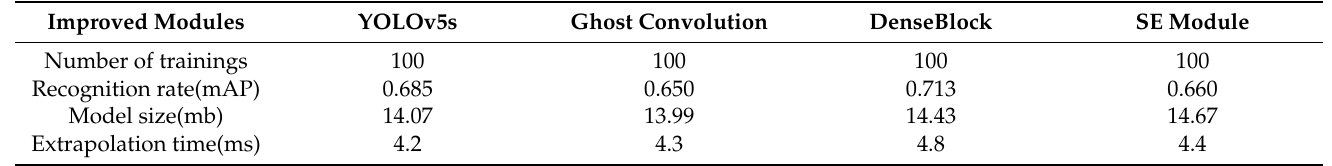
Table 5. Comparison table of results for individual module.